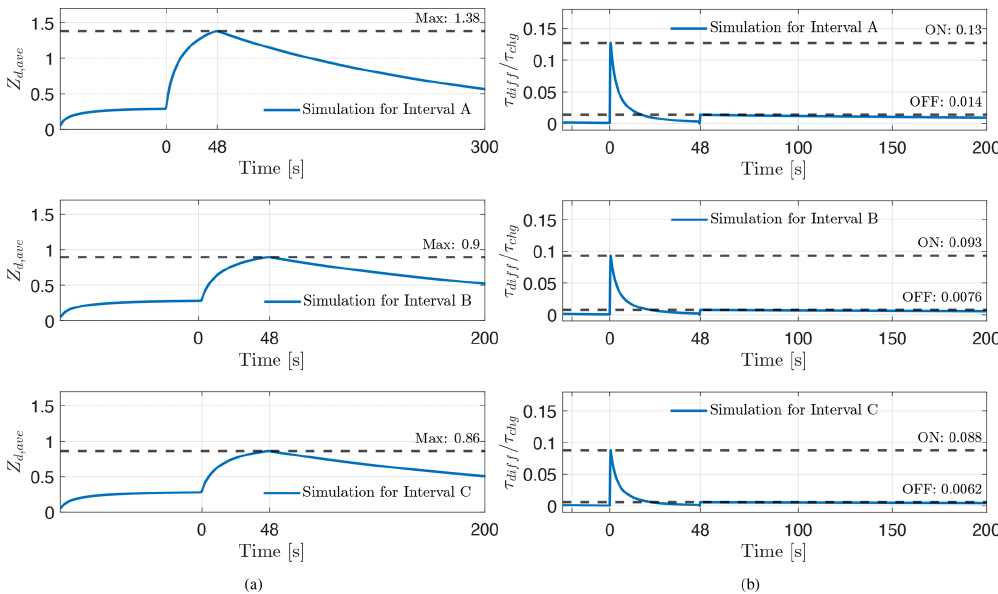
Figure 18. Simulations of average dust charge number on (a) for each respective interval and the ratio between the diffusion time and the charging time scales for the same intervals on (b)